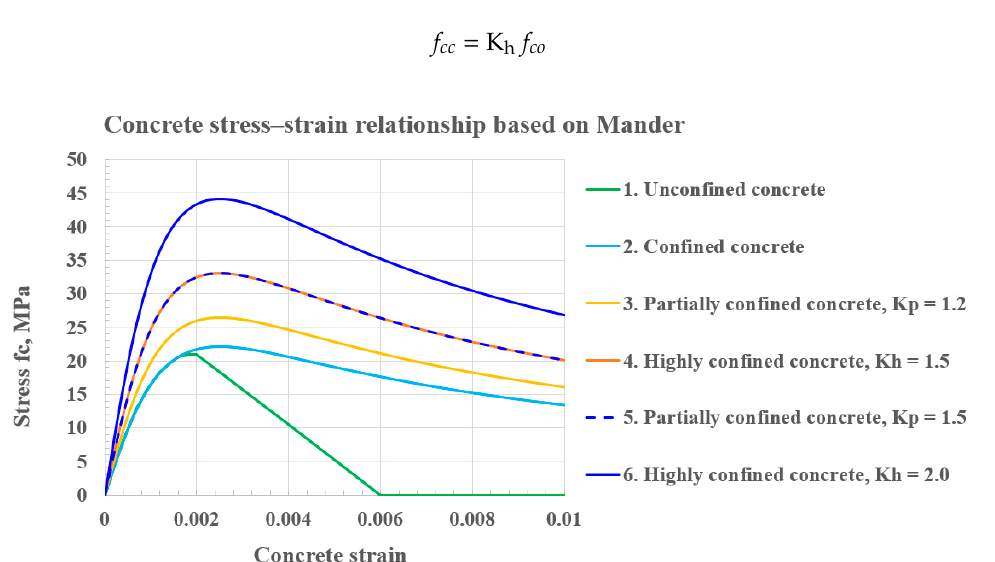
Figure 2. Concrete stress–strain relationships representing four zones (based on the confined Mander approach).